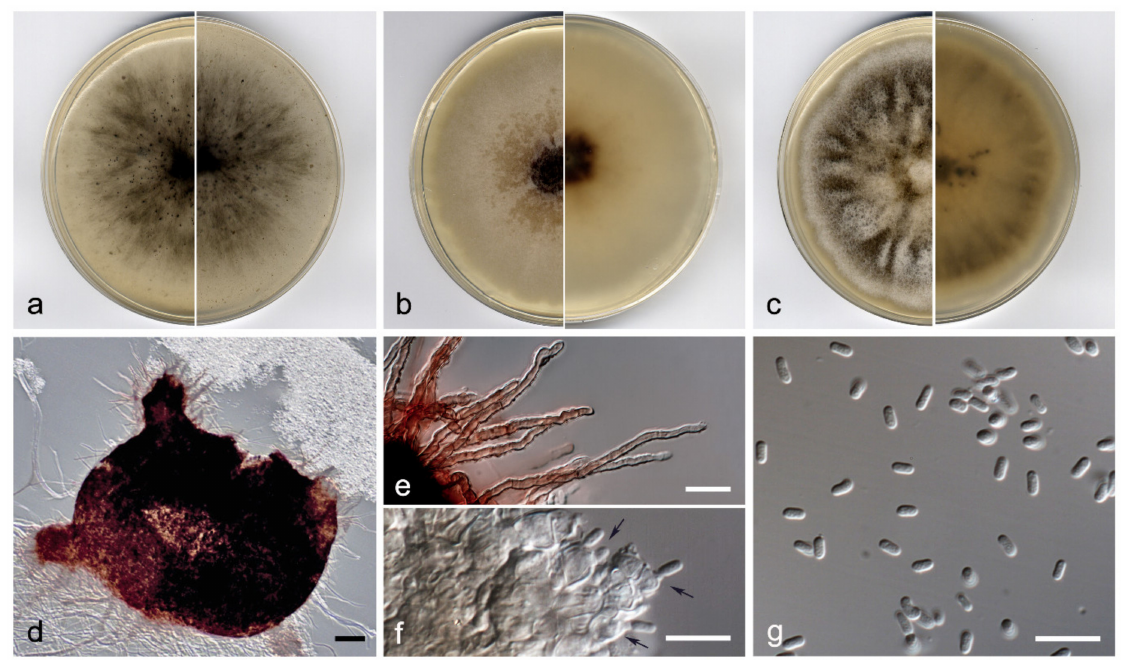
Figure 3. Didymella brevipilosa FMR 17415: ( a ) colonies on OA; ( b ) MEA; and ( c ) PDA after two weeks at 25 ± 1 ◦ C (surface, left; reverse, right); ( d ) pycnidium; ( e ) setae; ( f ) conidiogenous cells (black arrows); ( g ) conidia. Scale bars: ( d ) = 50 µ m, ( e , f ) = 10 µ